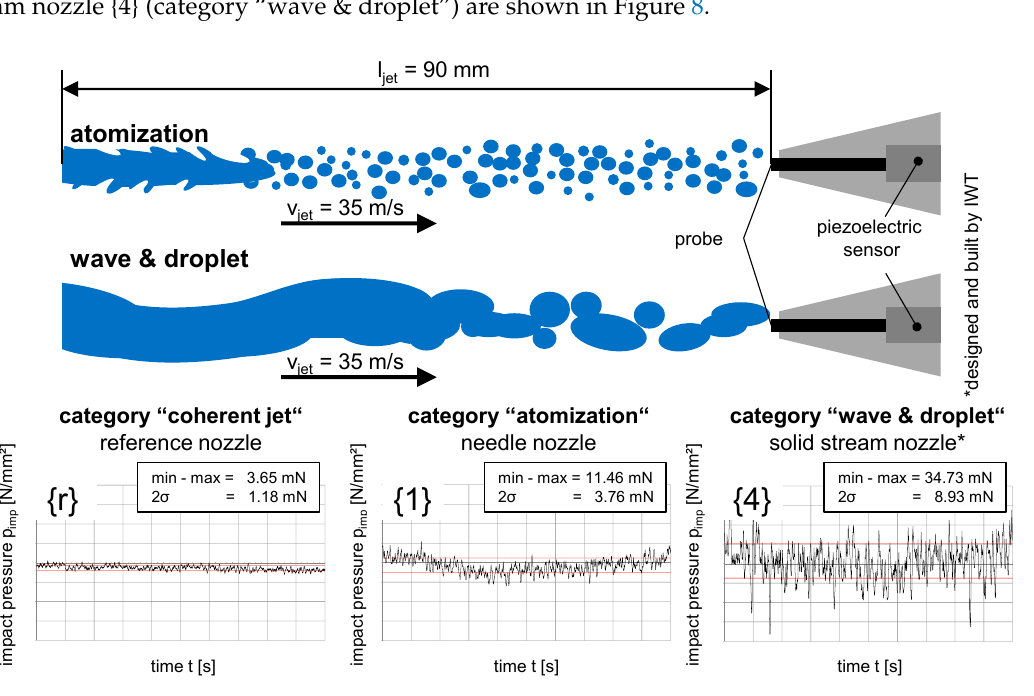
Figure 8. Characterization of the fluctuations in impact pressure for different jet breakups.